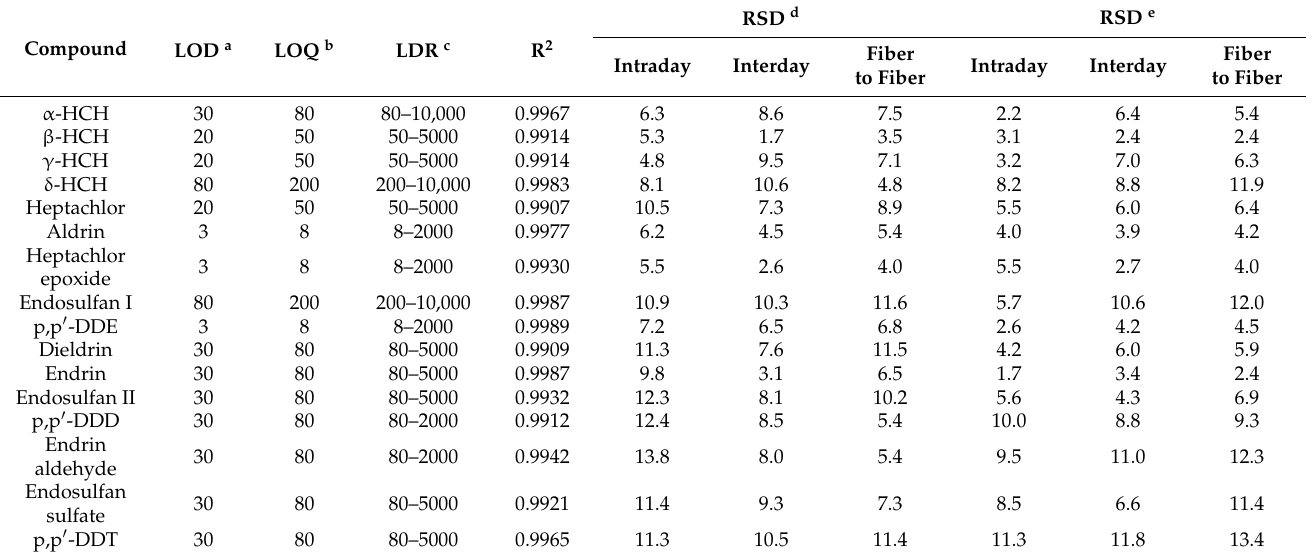
Table 1. Analytical data obtained by HS-SPME of OCPs mixture using the PET/nano-SiO 2 adsorbent.